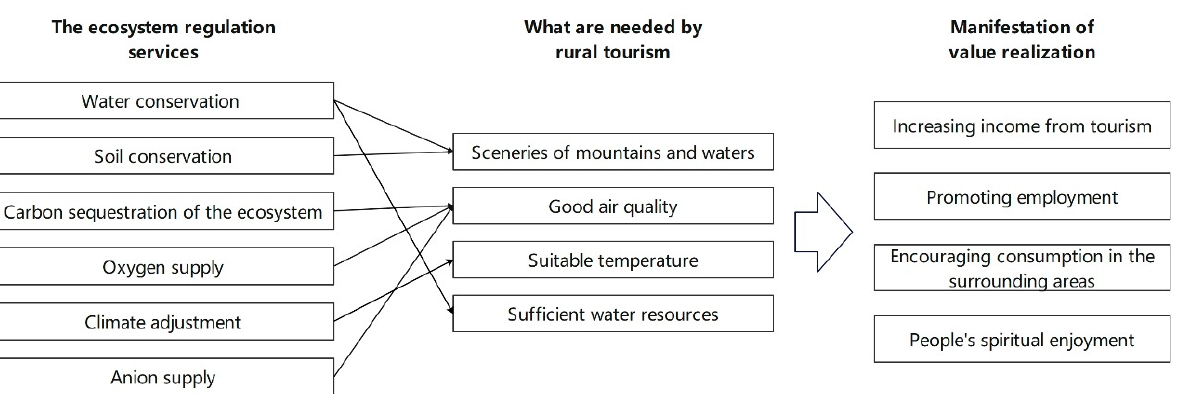
Figure 4. The supporting function of ecosystem regulation service to rural tourism.